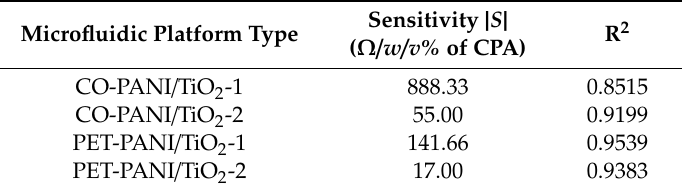
Table 1. Sensitivity and linearity of the analyzed structures.